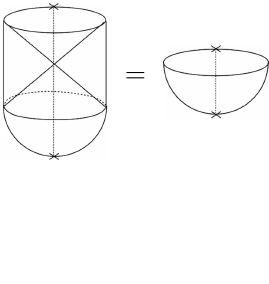
◦ θ y,z ⊗ x ◦ A y ∗ ⊗ ( z ⊗ x ) → ( x ⊗ y ∗ ) ⊗ z ( x ⊗ y ) ⊗ z → y ⊗ ( z ⊗ x )